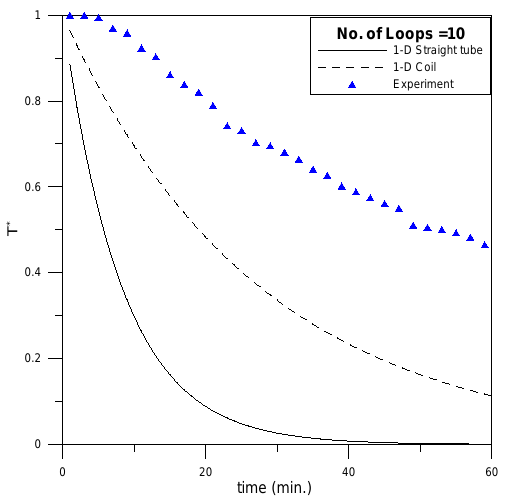
Figure 3. Impact of curvature on transient behavior of the coil. losses to the surroundings. The heat lost by the container to the surrounding does not exceed 0.5 % of the heat exchange between the coil and the water in the container. For such small amount of heat loss, the assumption of perfectly in- sulated system for the container is fair and reasonable.